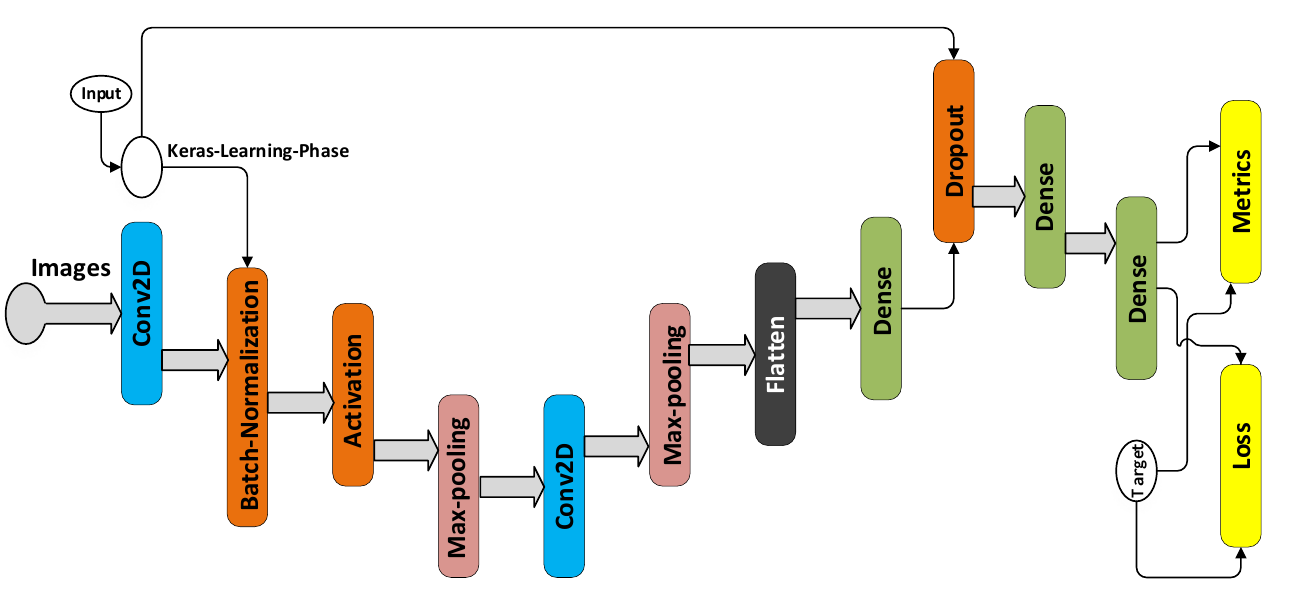
Figure 3. Architecture of the proposed